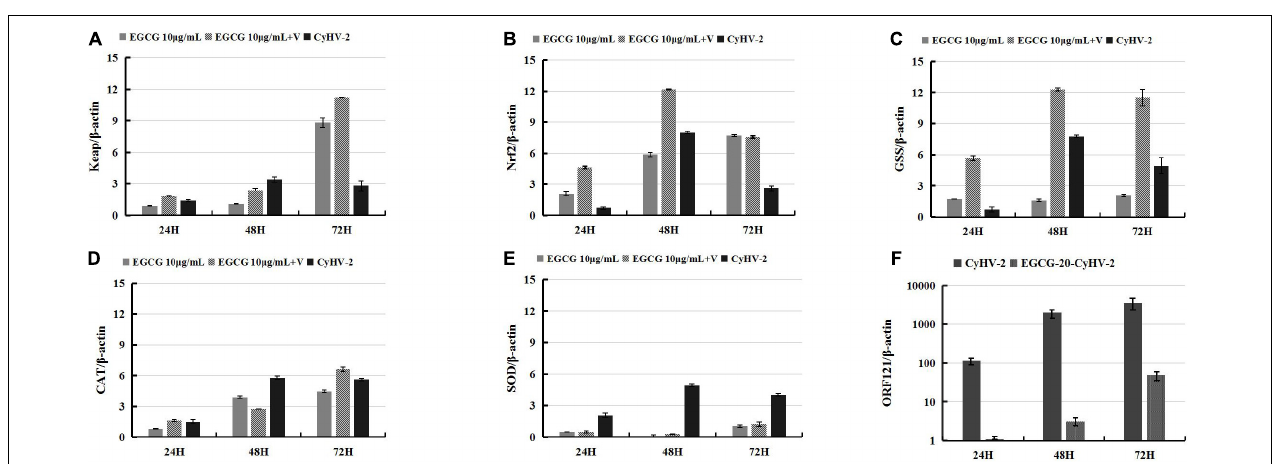
FIGURE 3 | Modulation of reactive oxygen species (ROS) accumulation during CyHV-2 infection in RyuF-2 cells. CyHV-2 with MOI = 1 was used to infect RyuF-2. Cell samples and supernatant after infection were obtained at 6, 12, 24, 36, 48, 60, 72, and 92 h after infection. The DCFDA/H2DCFDA cellular ROS assay kit is used to detect changes in the accumulation of intracellular ROS after virus infection. The control group cells were used as the normalization standard to reduce the differences between groups. The results are shown in (A) . After infection, the supernatant was used to obtain total DNA for detection of virus amplification. The early gene ORF121 was used as a representative gene for detection of CyHV-2 replication, as shown in (B) . The RT-PCR results were processed using the absolute quantification standard program, and the data were expressed as the mean SD.